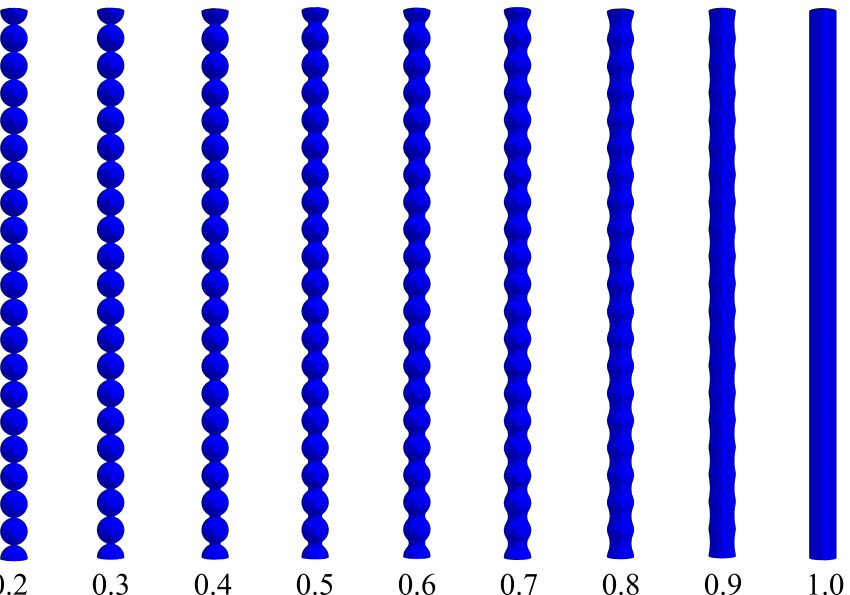
Figure 6. Computational models of the model pore walls in the reference state for different x / R ratios.